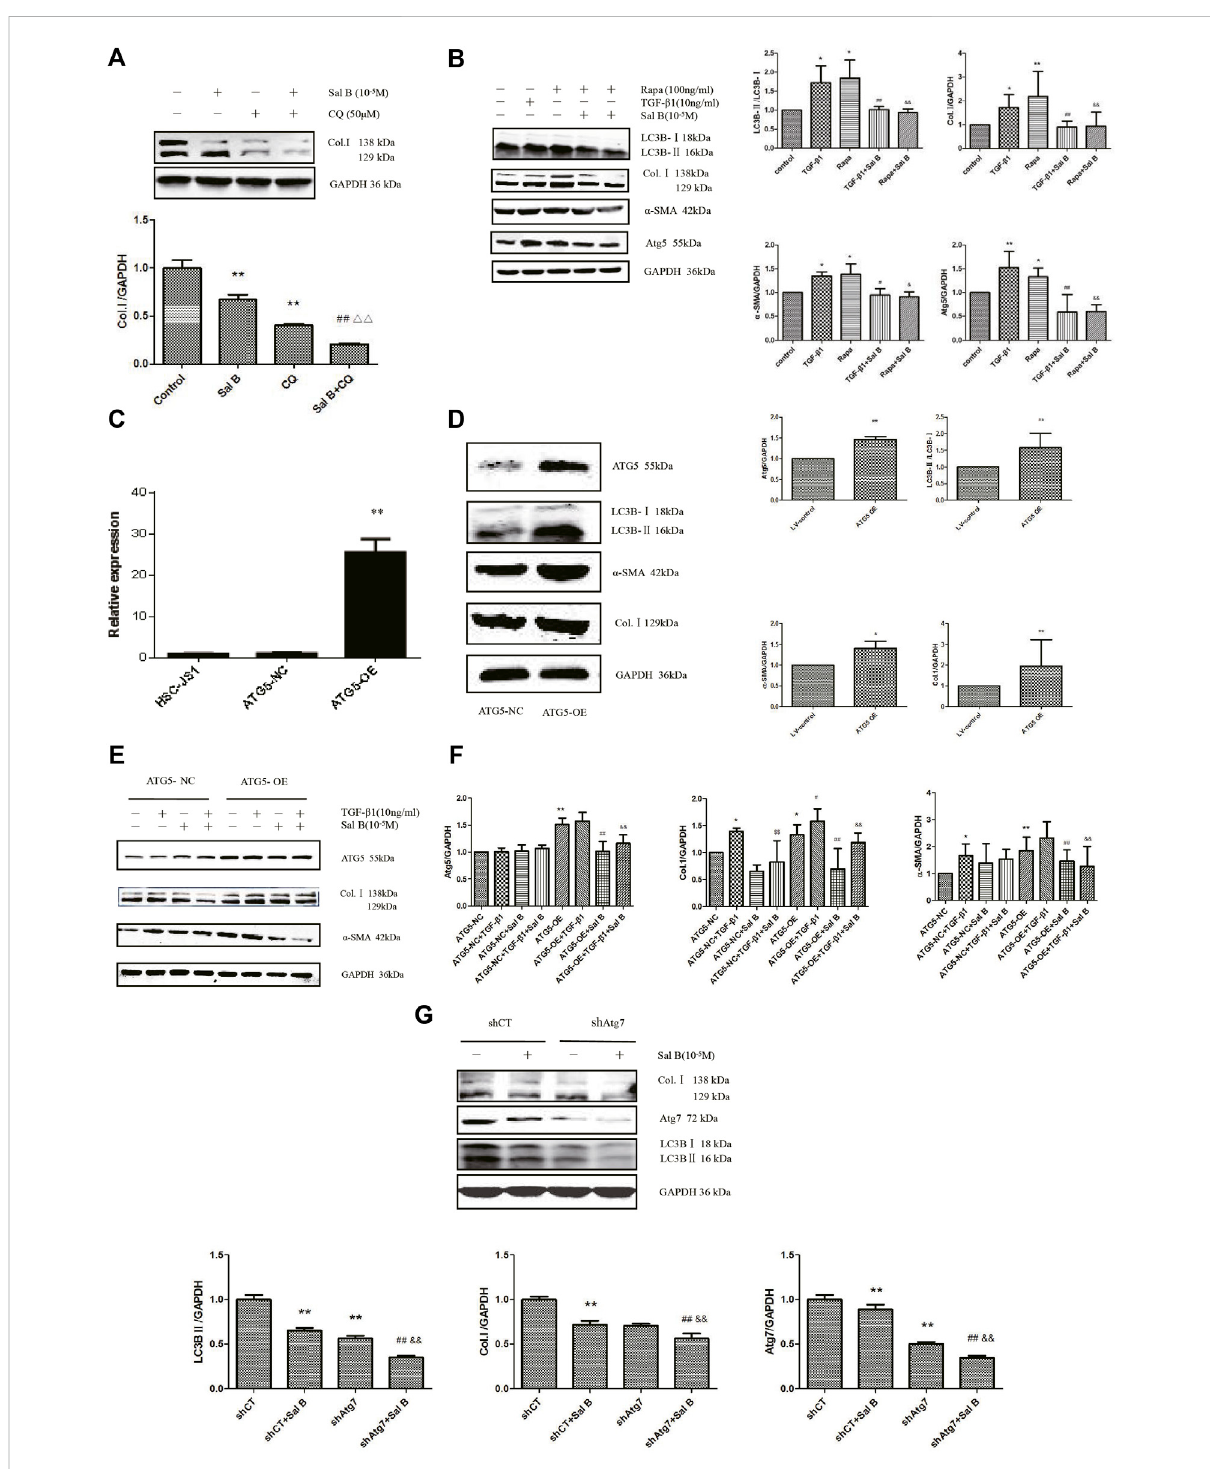
FIGURE 2 SalBinhibitsJS1activation inducedbyTGF- β 1throughautophagy. (A) EffectofSalBandCQ,anautophagyinhibitors,ontheexpressionofCol. Ⅰ in JS1. (B) Effect of Sal B and Rapa, an autophagy agonist, on the expression of Col. Ⅰ , α -SMA, Atg5, and LC3B. (C) Expression of ATG5 mRNA was detectedby qPCR. (D,F) Effect ofATG5-OEon theexpression ofAtg5,LC3B, α -SMA,and Col.I. (E) Effect ofSal Bontheexpressionof Atg5,Col.I,and α -SMA in overexpressionof ATG5 JS1. (G) Effect of Sal B on theexpression of Col.I, Atg5, and LC3B in interferenceof ATG7 JS1. N =3( N = 3, vs. control: p p < 0.05, pp p < 0.01;vs.SalB,##: p < 001;vs.CQ, △△ : p < 0.01;vs.3-MA, && : p < 0.01; (C) vs.ATG5-NC, pp : p < 0.01 (D,E) vs.ATG5-NC,*: p < 0.05, **: p < 0.01 (F) vs. ATG5-NC,*: p < 0.05,**: p < 0.01; vs. ATG5-OE, #: p < 0.05, ##: p < 0.01; vs. ATG5-NC + TGF- β 1, ¥: p < 0.05, ¥¥: p < 0.01; vs. ATG5-OE+TGF- β 1,&: p < 0.05, && : p < 0.01.Gvs.shCT,**: p < 0.01;vs.shAtg7,##: p < 0.01;vs.siCT+SalB, && : p <